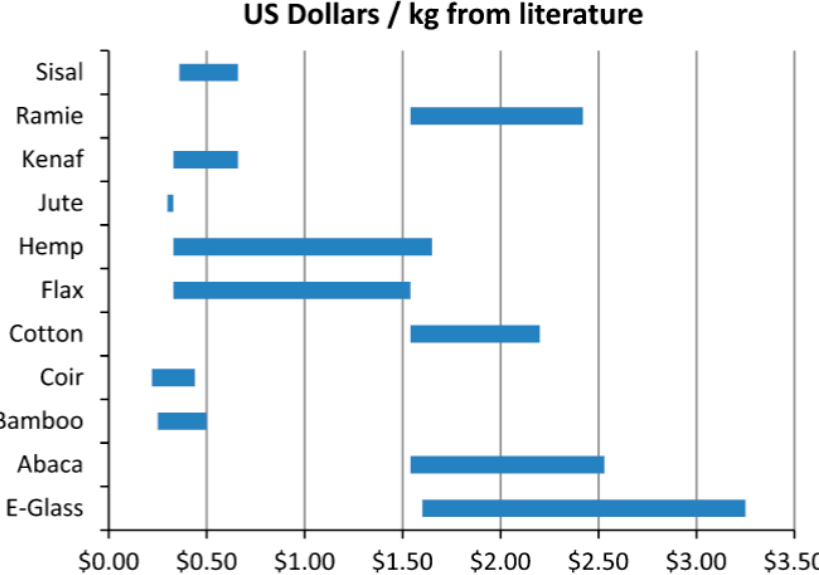
Figure 1. The cost of different natural fibers and E-glass fiber per kilogram in US dollars [11] (reproduced with thanks from Elsevier, License Number: 5206321182202).